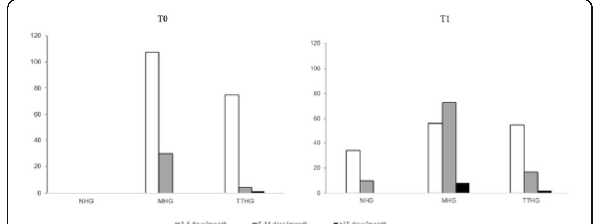
Fig. 1 (abstract P036). See text for description